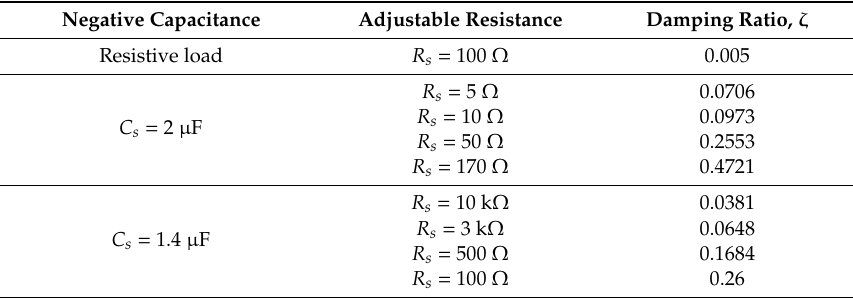
Table 2. Comparison of damping ratio shown in Figure